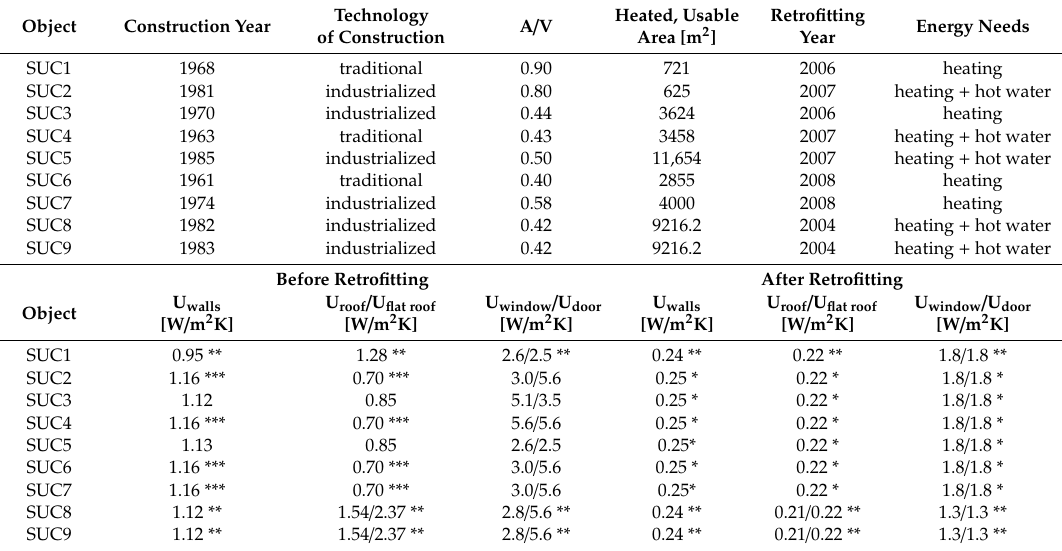
Table 1. Basic parameters of the buildings examined for energy